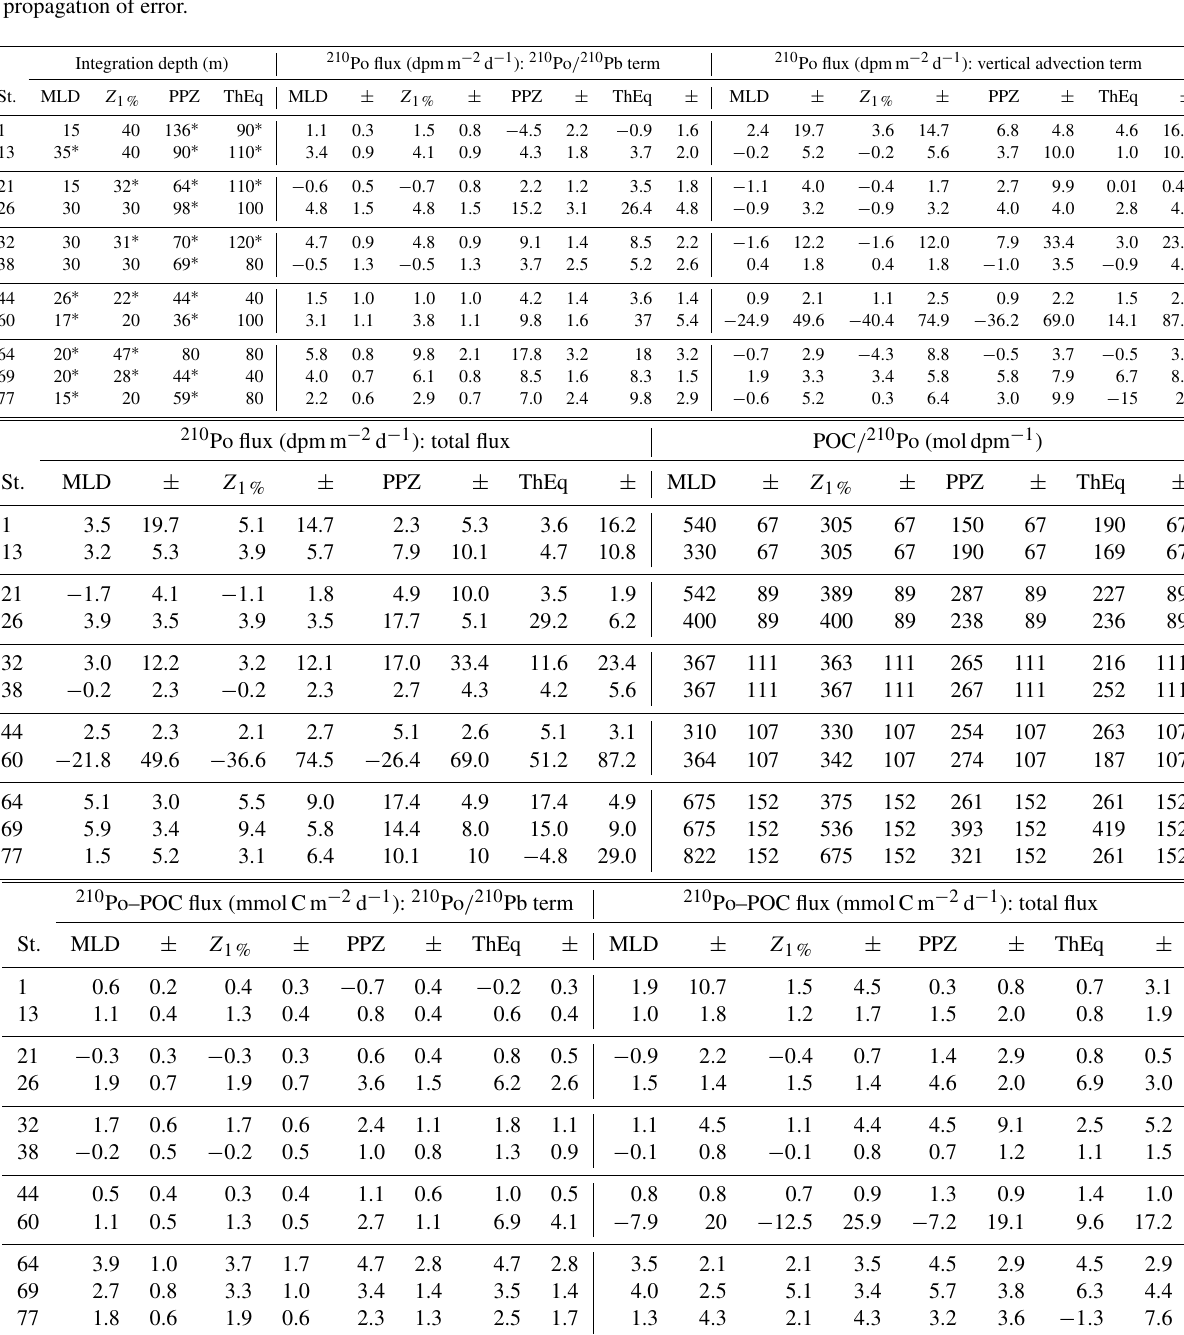
Table 2. The total 210 Po flux as the sum of the flux calculated from the deficit and vertical advection, together with POC / 210 Po ratios in particles >1µm (derived from the power law function in Fig. 5) and POC fluxes derived from 210 Po at the corresponding depths. The uncertainties of 210 Po export flux are associated with the activity uncertainty of the radionuclides. The error for the calculated particulate POC / 210 Po ratio in each basin is the standard error of regression. The uncertainties of the 210 Po-derived POC flux were estimated based on the propagation of